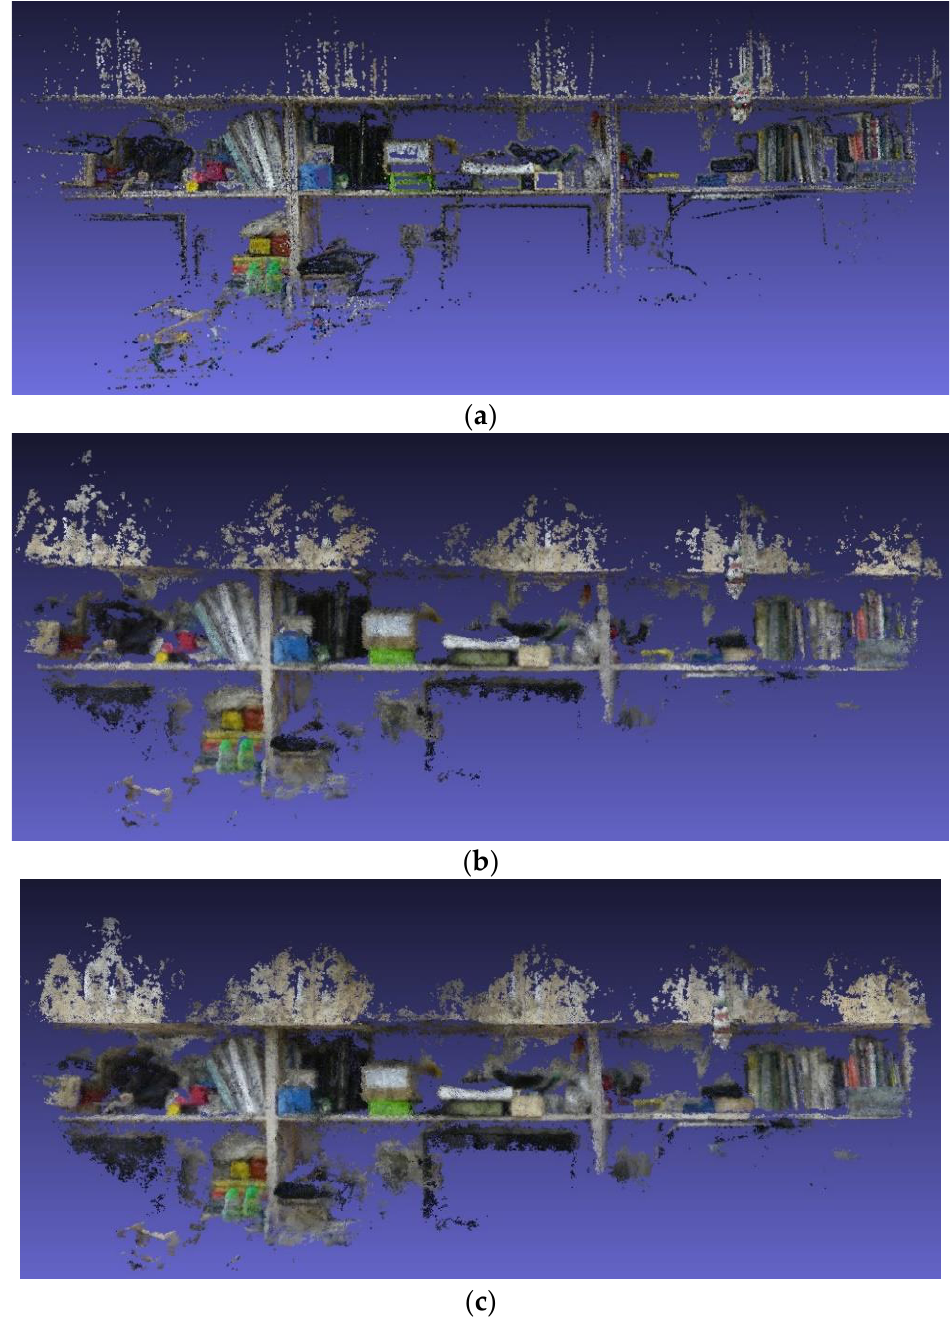
Figure 18. Overall 3D reconstruction results of the different methods. ( a ) Traditional method; ( b ) MVSNet; ( c ) CES-MVSNet.